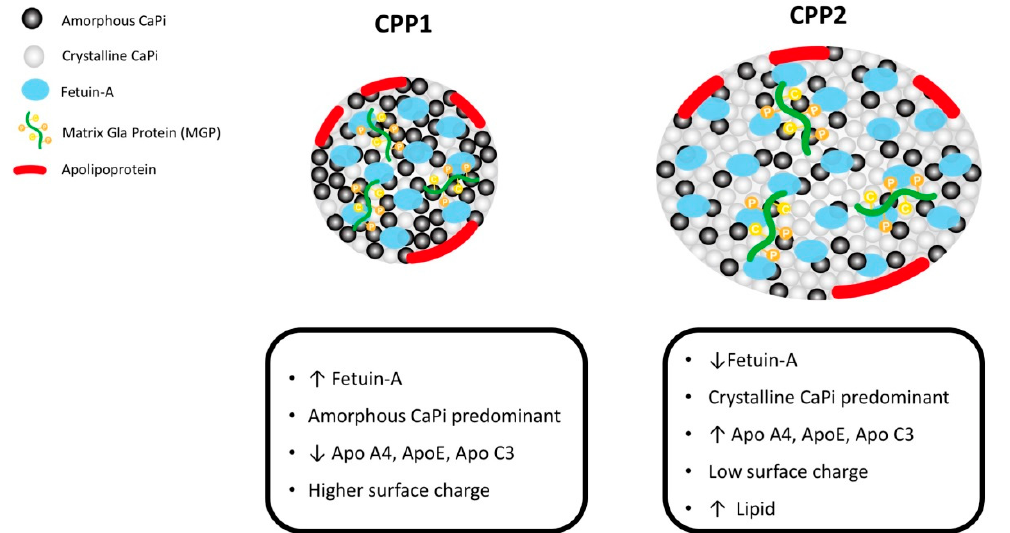
Figure 1. Components of calciprotein particles (CPPs): CPPs are composed of 18% mineral, 80% fetuin-A, and 2% matrix Gla protein [11]. CPP1 is round with a diameter of 60–75 nm and is mainly composed of amorphous calcium phosphate, which exists as a colloid. Secondary CPP (CPP2) includes hydroxyapatite calcium that results from calcium phosphate crystallization over time in the core and has a diameter of 120–150 nm. The strong negative charges in the β sheet of the cystatin-like D1 domain of fetuin-A are thought to promote binding with calcium phosphate as well as prevent its growth, aggregation, and precipitation. Compared with CPP1, CPP2 has a lower level of fetuin-A, lower surface charge, and higher apolipoprotein